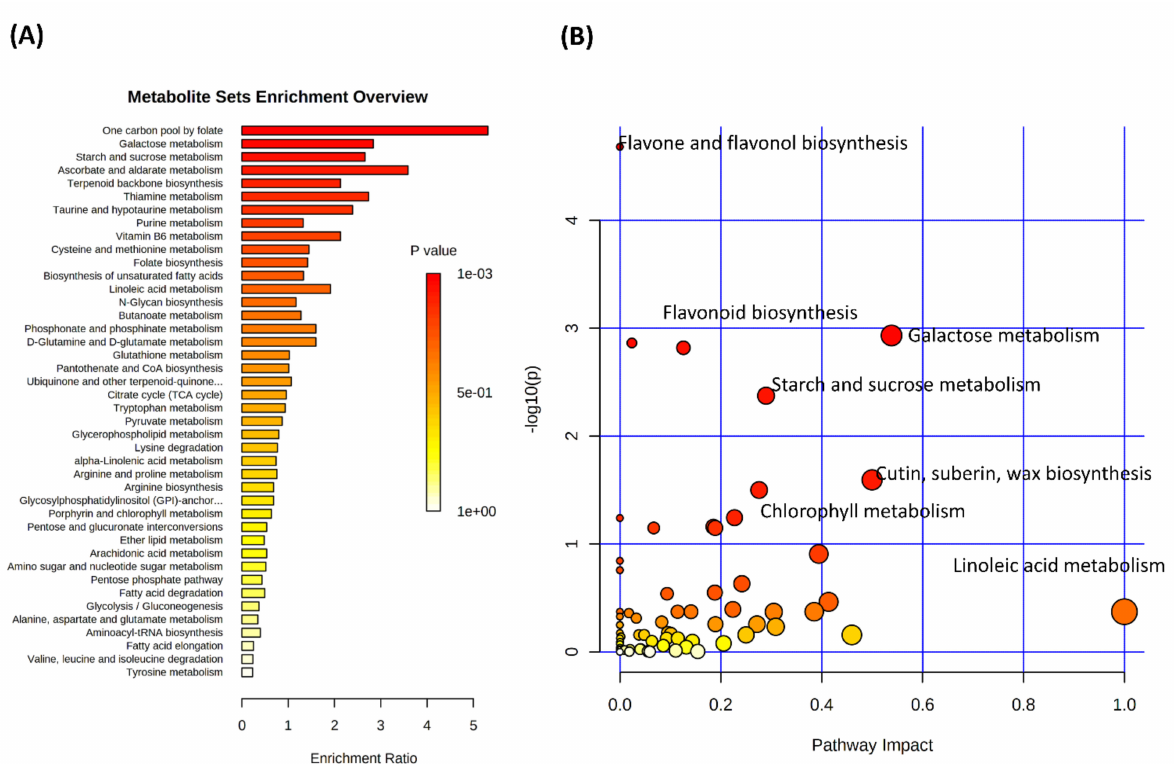
Figure 7. Enrichment analysis of the key metabolites responding to drought on the Brachypodium central subpopulation. Eight-week-old Brachypodium accessions were transferred to the National Plant Phenomics Centre, Aberystwyth, UK. The watering was regulated to soil water contents (SWC) of 15% (droughted, DRO), 40% and 75% (controls, CON). After 12 days of drought, leaves were sampled and the metabolomes were assessed using FIE-HRMS. Key variables changing in Brachypodium accessions within the central subpopulation (Turkish climatic regions 1a, 1c) [6] with drought and related to amino acid were identified and assessed using ( A ) metabolite set enrichment analysis (MSEA) or ( B ) the mummichog algorithm where significantly enriched pathways are also ranged for biological